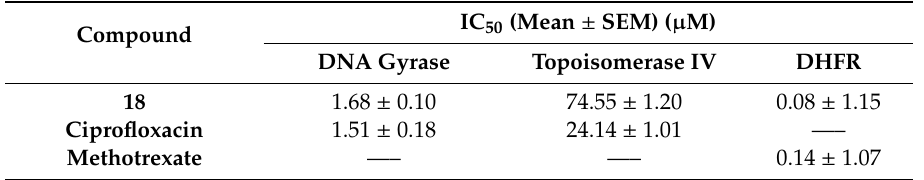
Table 4. Inhibitory assessment (IC 50 in µ M) of compound 18 on Staphylococcus aureus DNA gyrase, Topoisomerase IV and Dihydrofolate reductase